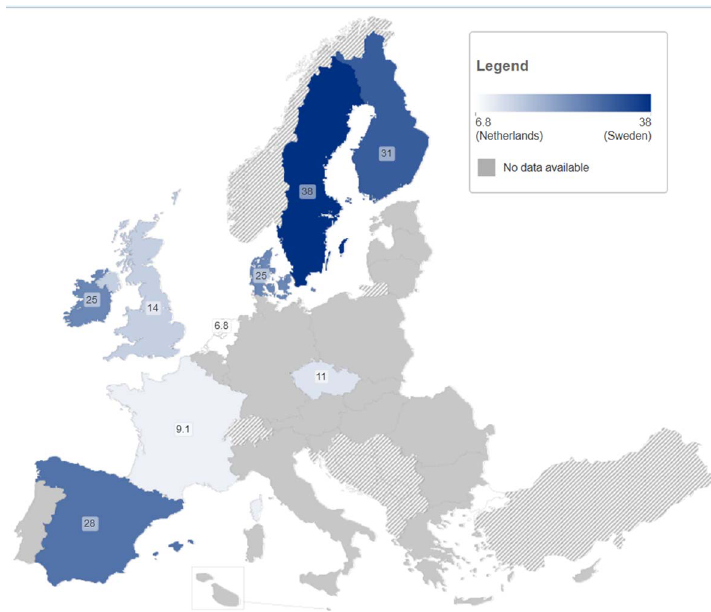
Figure 2. Incidence of HCV infection in PWID (per 100 person years).